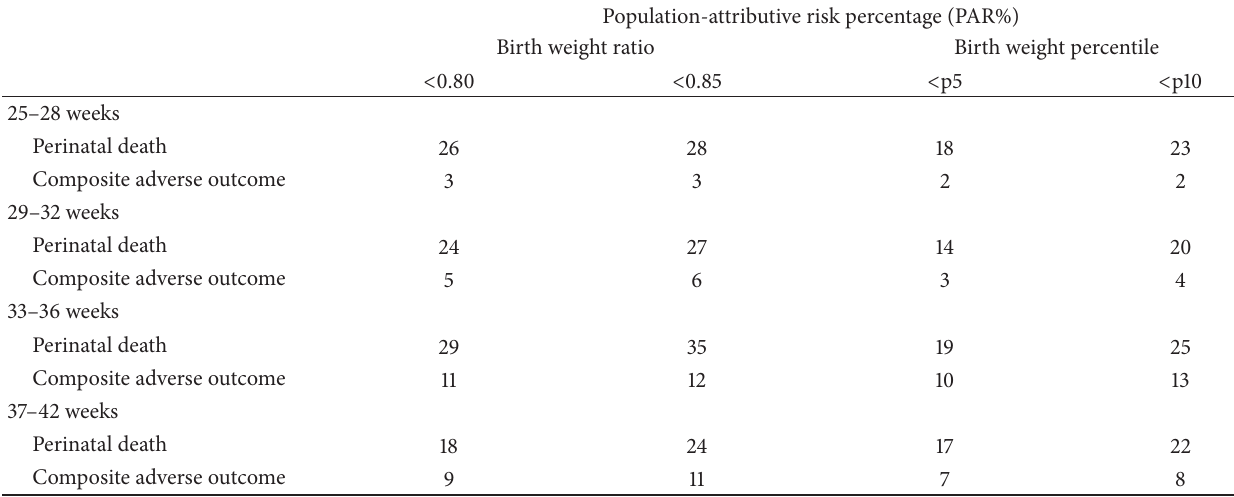
Figure 3: Incidences of adverse perinatal outcome stratified by gestational age at delivery separate for birth weight ratio (a) and birth weight percentiles (b). Table 2: Population-attributive risk of abnormal fetal growth, for four definitions of abnormal growth by birth weight ratio and birth weight